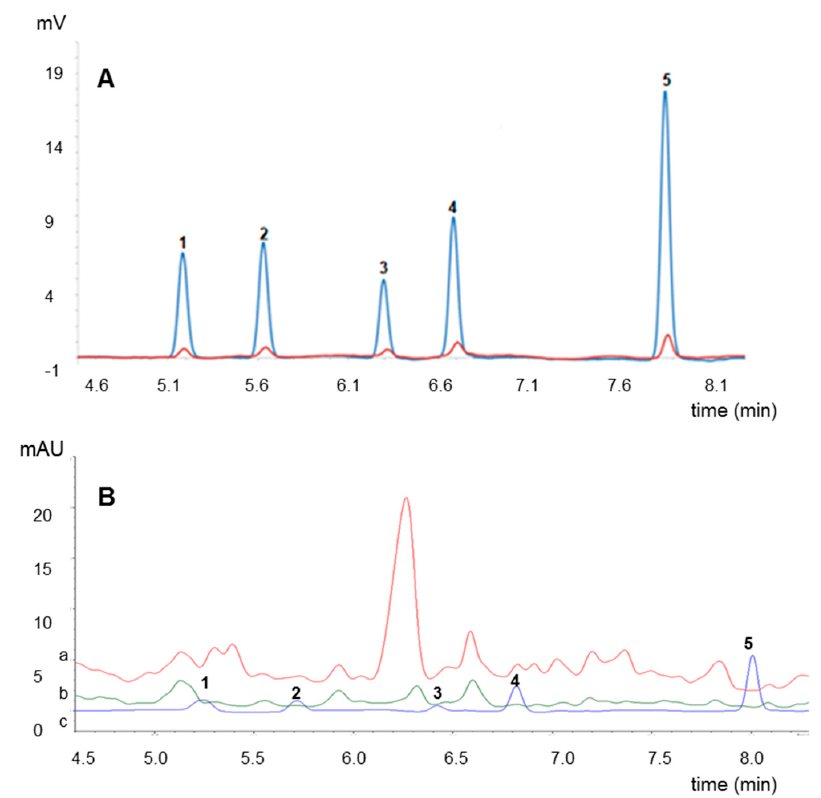
Figure 1. An exemplary chromatogram of standards solution ( A ) and chromatograms of neonicotinoids-free acacia honey samples ( B ) after: extraction process (a), extraction and purification (b), in comparison with a chromatogram of target compounds (c), all of them obtained at the wave length 245 nm; where 1—thiamethoxam, 2—clothianidin, 3—imidacloprid, 4—acetamiprid and 5—thiacloprid.